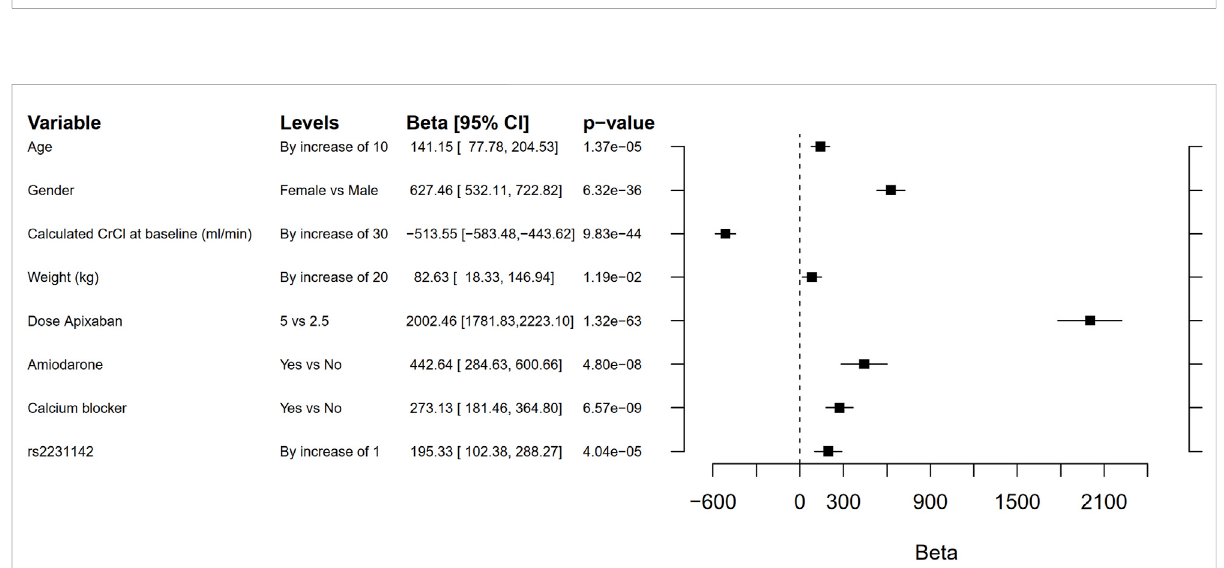
FIGURE 2 Box-plot of the PK parameters by the SNP rs2231142. AUC ss , area under the curve at steady state; C max,ss , maximum serum concentration at steady state; C min,ss , serum trough concentration at steady state; n, number of genotype carriers; the box represents the lower and upper quartile whereasthethickmiddle linedenotes themedian.The whiskersextendtothemaximumandminimumvaluewithin 1.5timestheinterquartilerange and values outside of these limits are presented as circles.